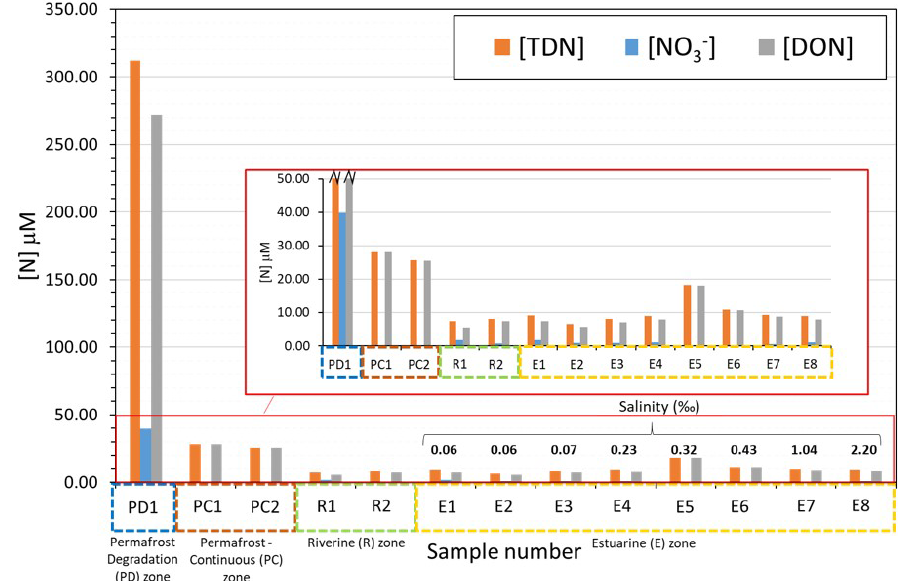
Figure 3. Concentrations of total dissolved nitrogen (TDN), nitrate (NO − lower Kolyma River, as overviewed in Fig. 1a. Salinity values are displayed for the estuarine samples in order of increasing salinity. The inserted panel shows the small-scale differences on downstream sites.